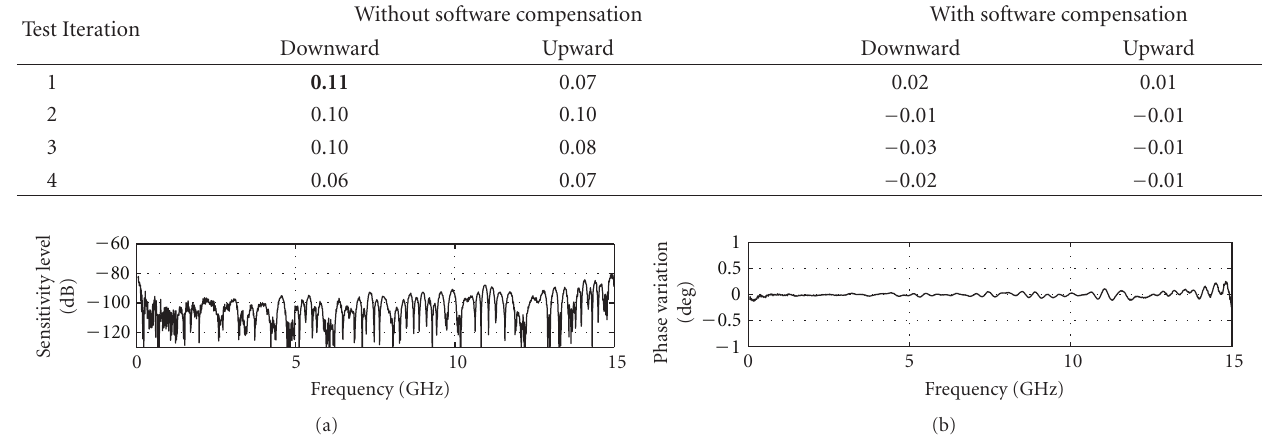
Figure 4: Sensitivity calculated using two successive static